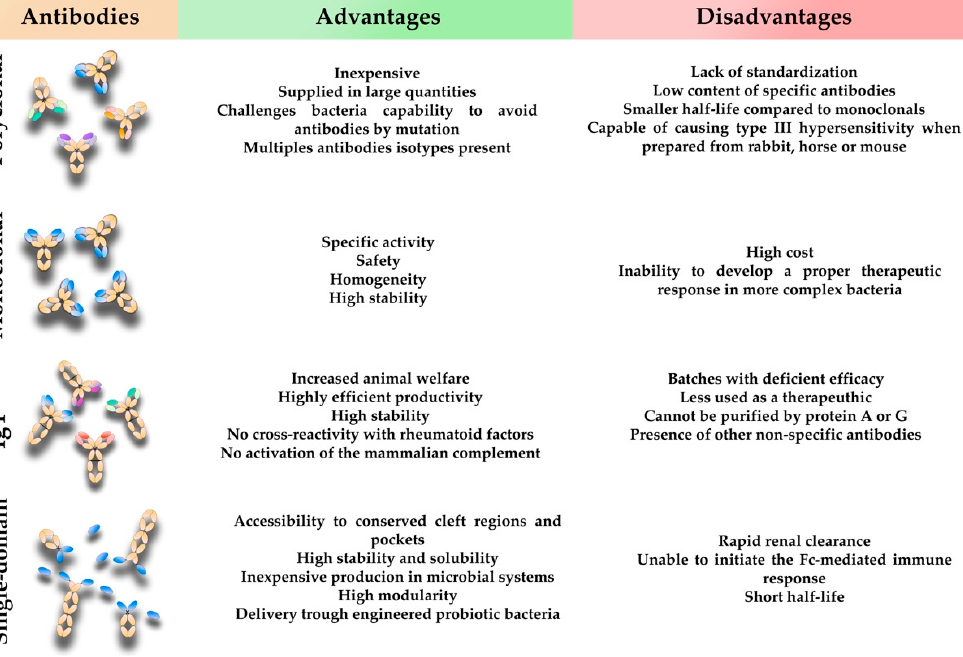
Figure 4. Main advantages and disadvantages of the four types of antibody formats discussed in this